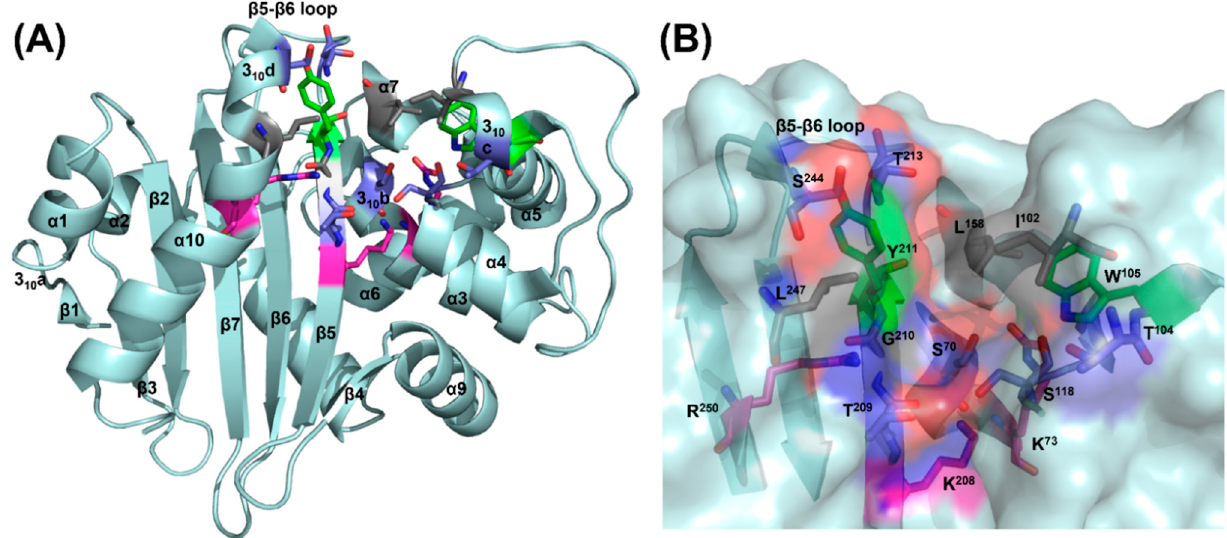
Figure 2. Potential residues that may be involved in substrate recognition and catalysis of OXA-48. ( A ) The secondary structures and motifs; ( B ) the important residues in the active pocket studied in this work are shown as gray (hydrophobic